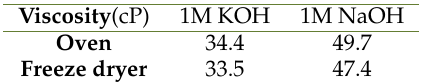
Table 2. Viscosity reading for sample